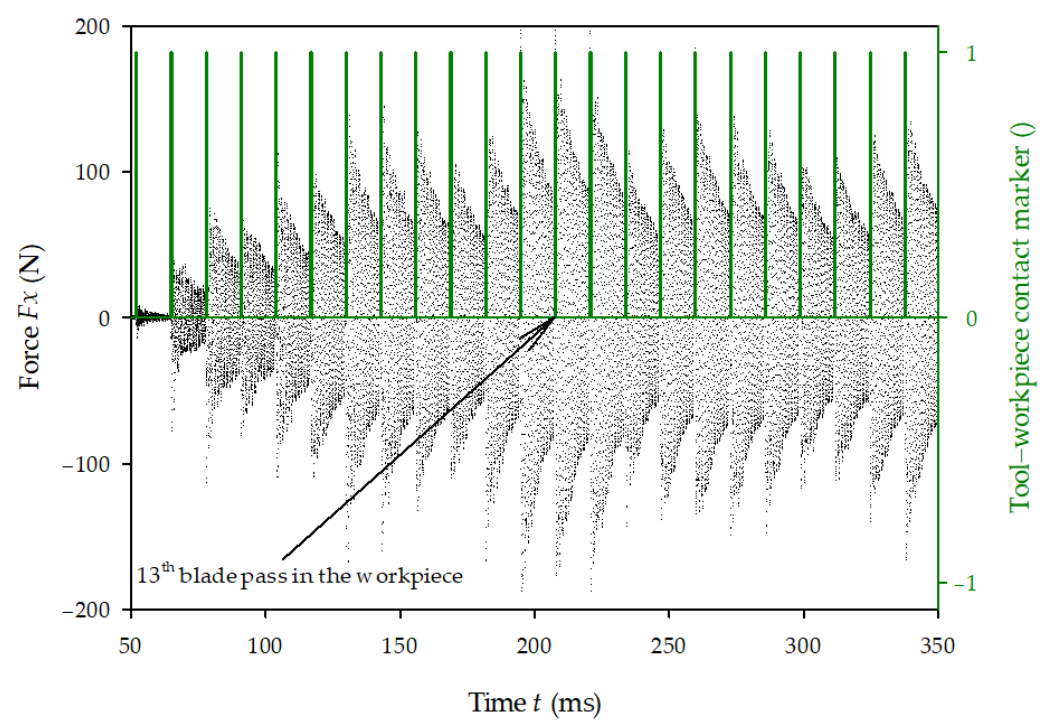
Figure 6. Raw force F x signal (black dots) and tool impact indicators (green lines). The resultant force F r and angle α were calculated using Equation (3), and